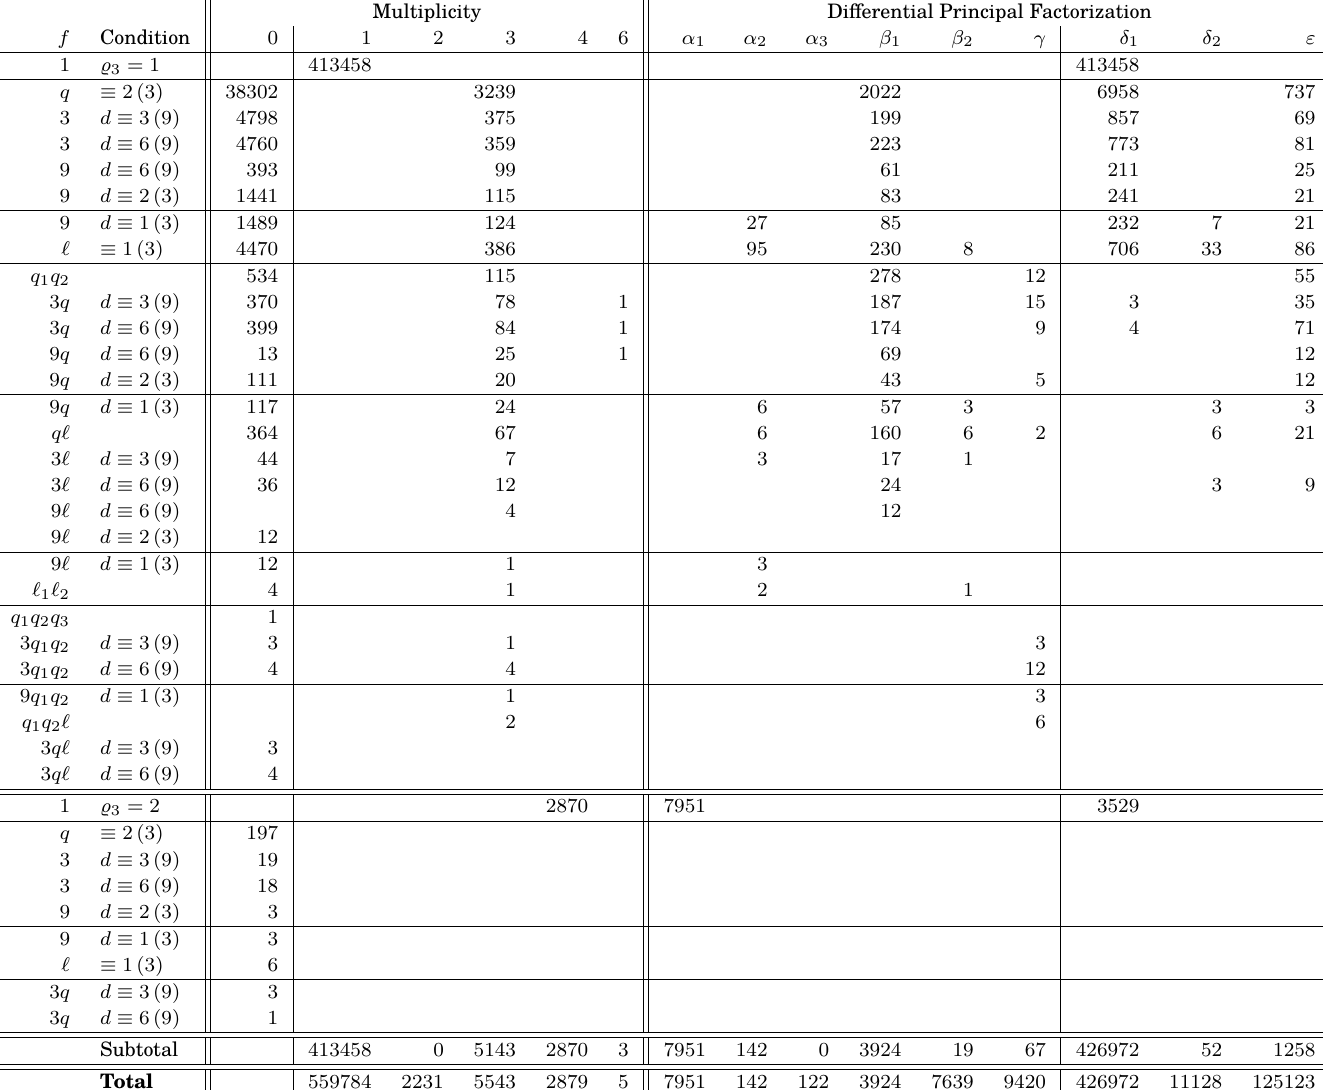
Table 14: Table 13 with 0 < d L < 10 7 continued for (cid:37) 3 ≥ 1